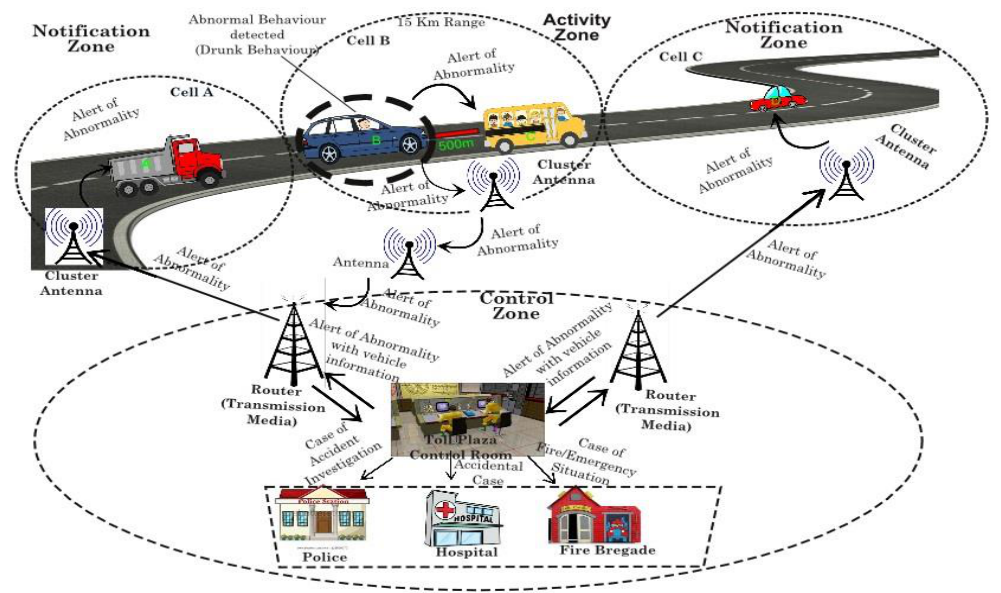
Fig. 6. Pictorial representation of Communication regarding Abnormalities on the